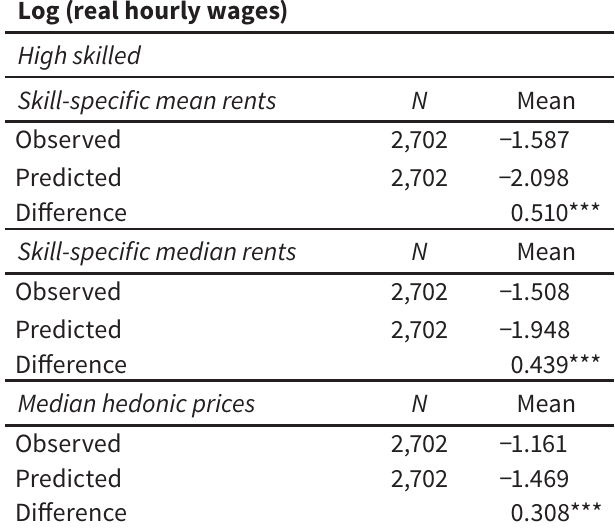
Observed and predicted real wage differences using different measures of living costs